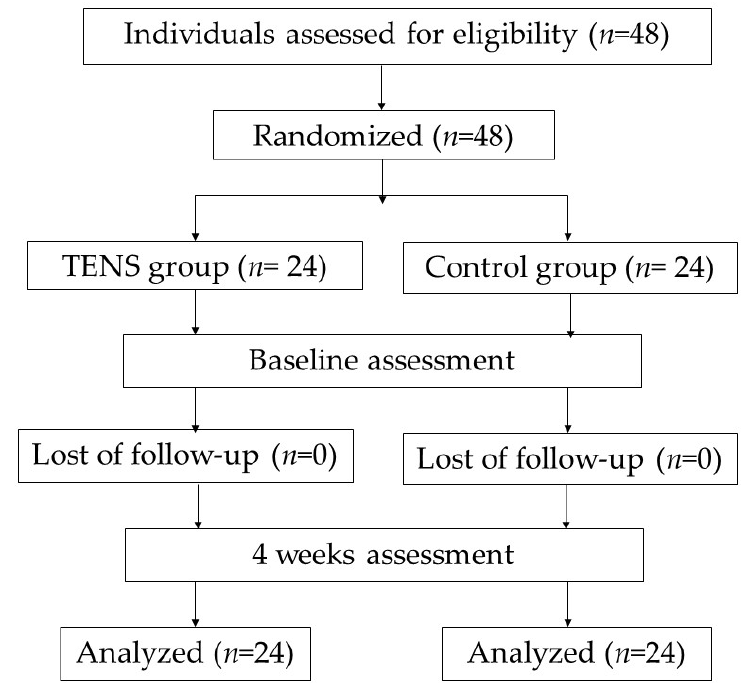
Figure 1. Flowchart of diagram.